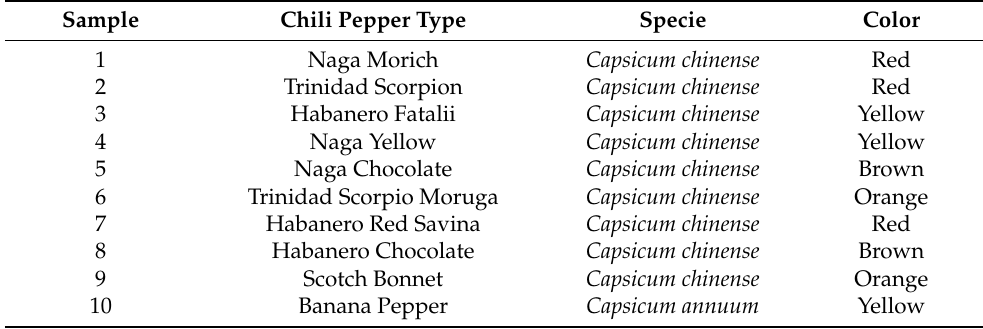
Table 1. Chili peppers samples (1–17) and flavored chili pepper EVOOs (18–20)